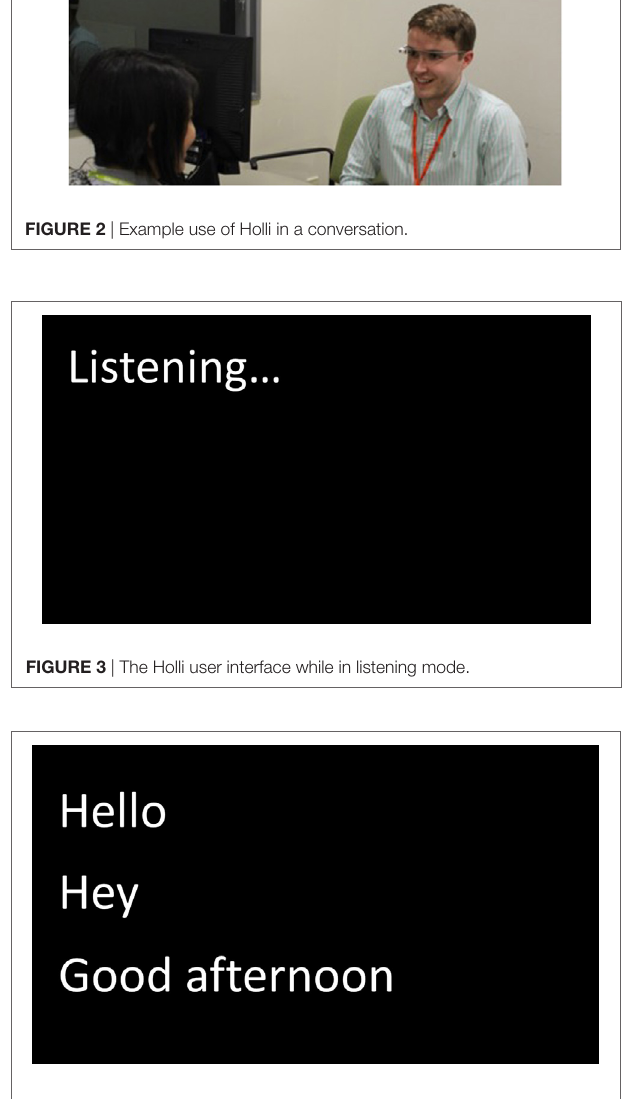
FigUre 4 | Examples of Holli prompts.